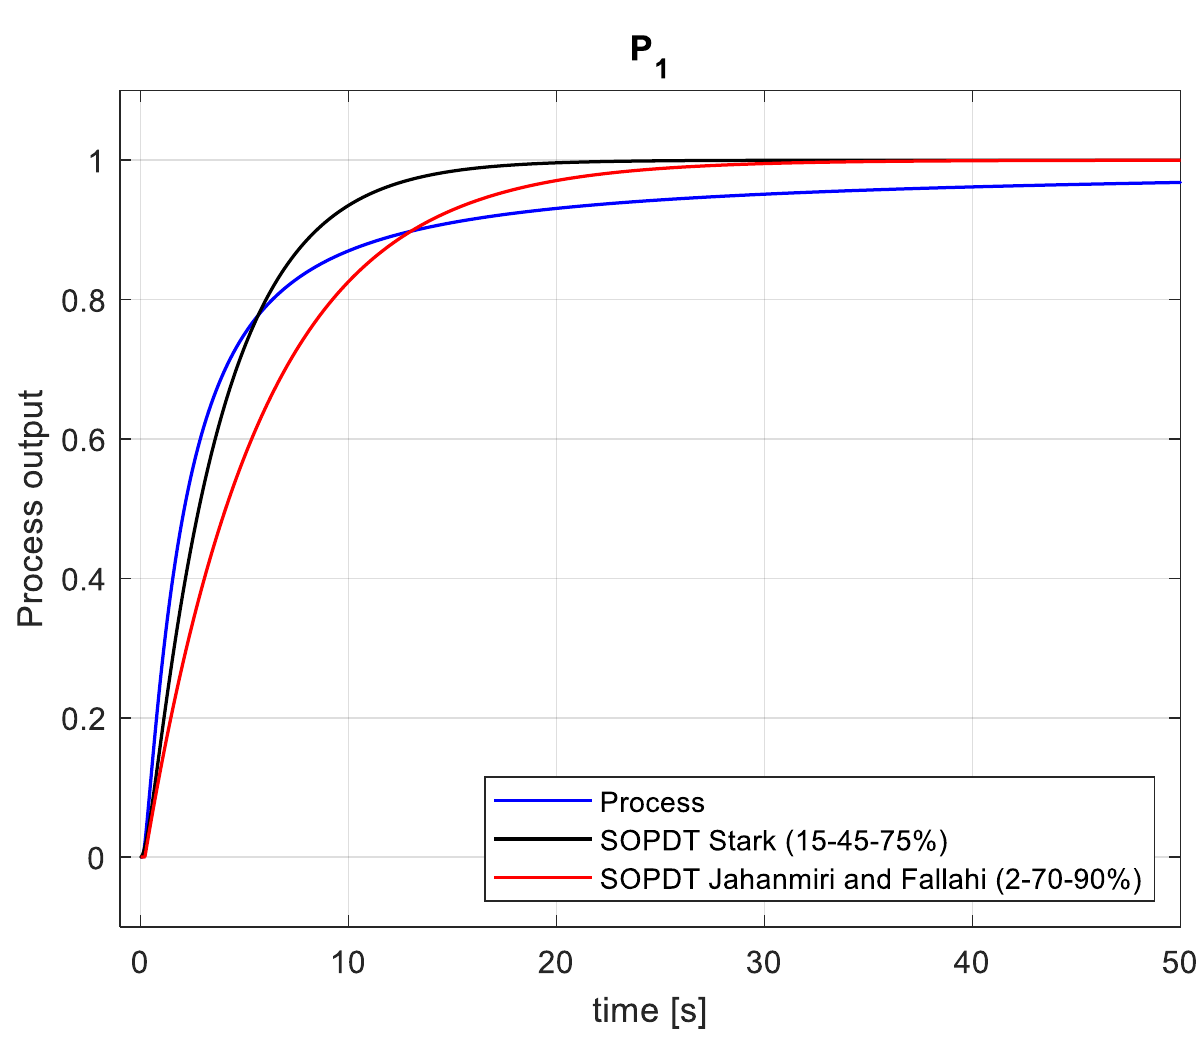
Figure 12. SOPDT model step responses using methods proposed by Stark [16] (15-45-75%) and by Jahanmiri and Fallahi [15] (2-70-90%) and process reaction curve. Table 13. Comparison between the performance indexes obtained for the proposed method with different sets of points, symmetrical and asymmetrical, and the ones for several well-known methods for integer-order models. The number of samples N S for the whole range and for each interval are also